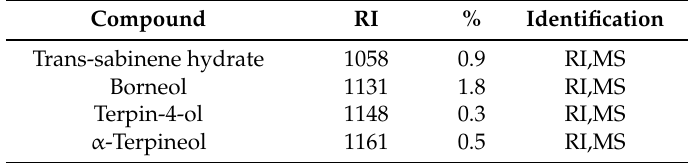
Table 1. Chemical composition of Teucrium pseudochamaepitys essential oil. RI, retention